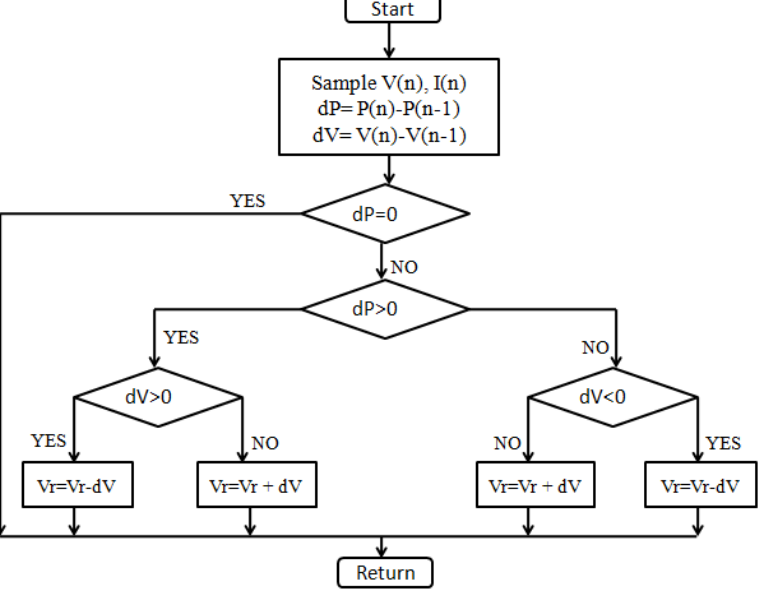
Figure 5. Flowchart of MPPT algorithm .